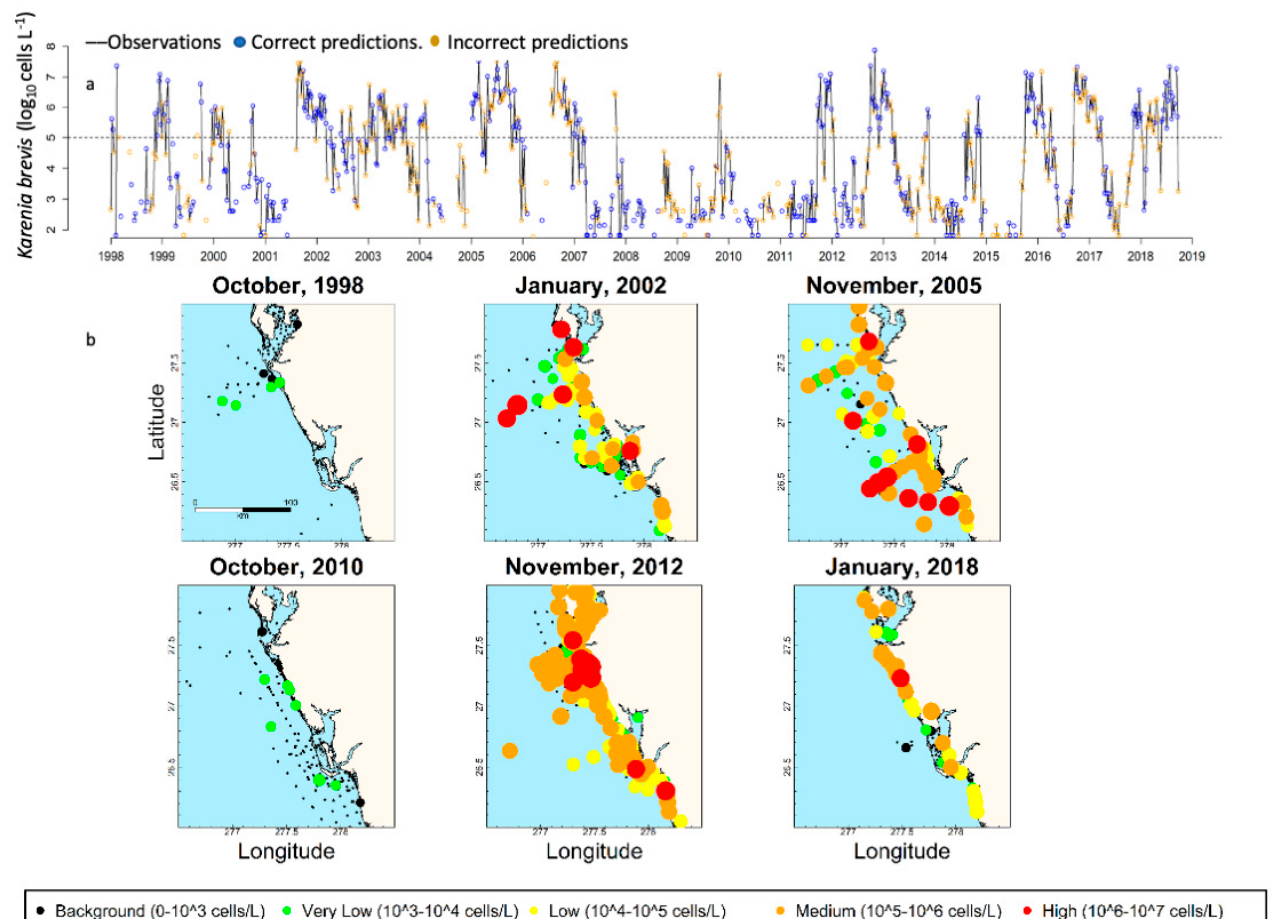
Figure 3. Comparison of Relevance Vector Machine (RVM) output and observational data of Karenia brevis. ( a ) Time series of the observed (black line) and predicted (blue and orange dots) area-averaged K. brevis concentrations from 1998 to 2018. Cell counts above 5 (log 10 cells L − 1 ; dashed line) are herein considered bloom conditions. ( b ) Snapshots of the observed K. brevis distribution in selected months. The twenty-one year timespan includes many years with blooms (2002, 2005, 2012, 2018) and without blooms (1998, 2010).